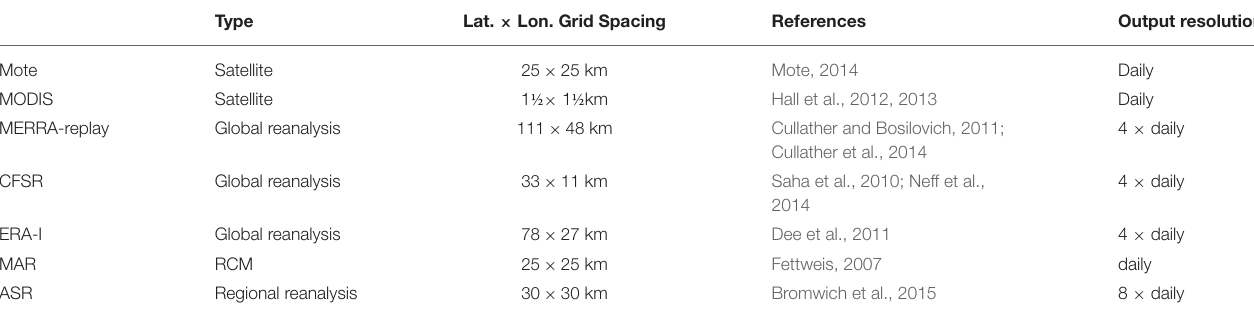
TABLE 1 | List of data sets examined in this